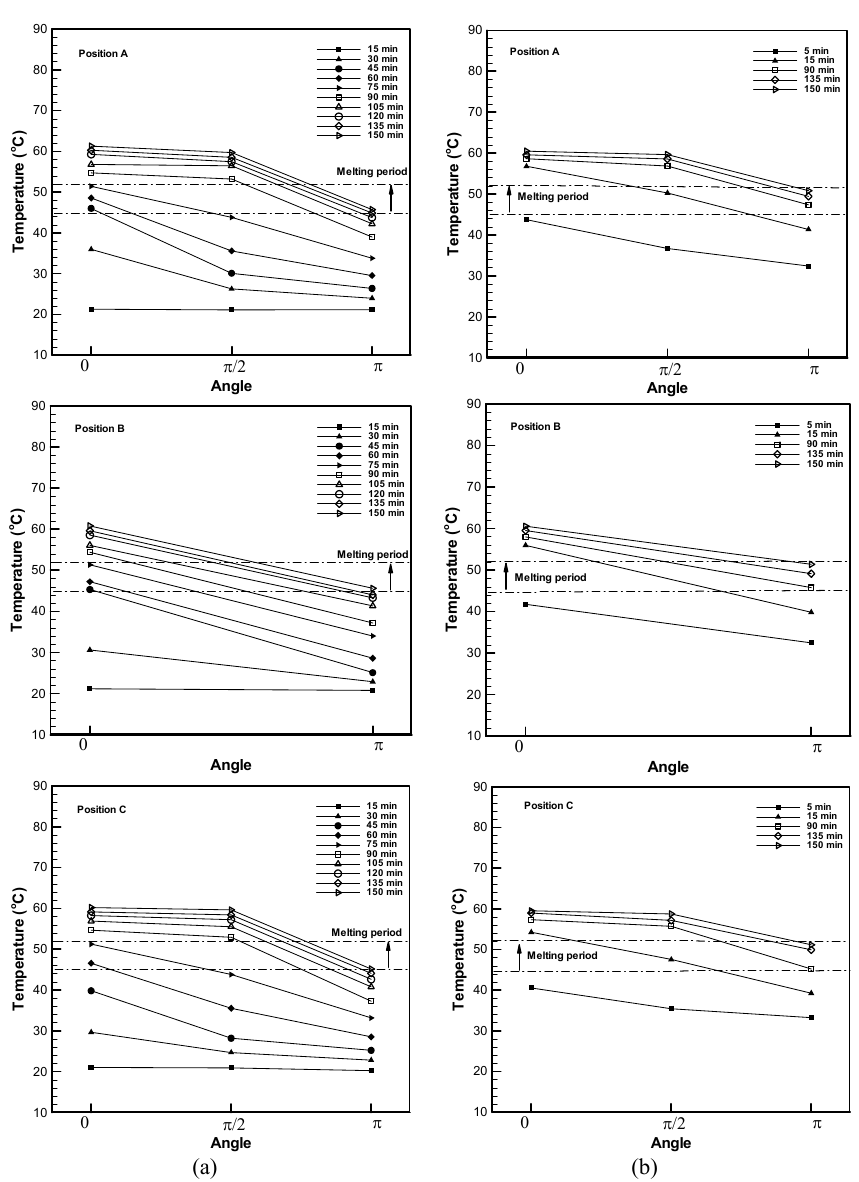
Figure 5. Experimental result of temperature distribution for 13mm height fins heat exchanger for different angles during charging process for Ste = 0.26: (a) 32.5mm radial distance and (b) 12.5mm radial distance.